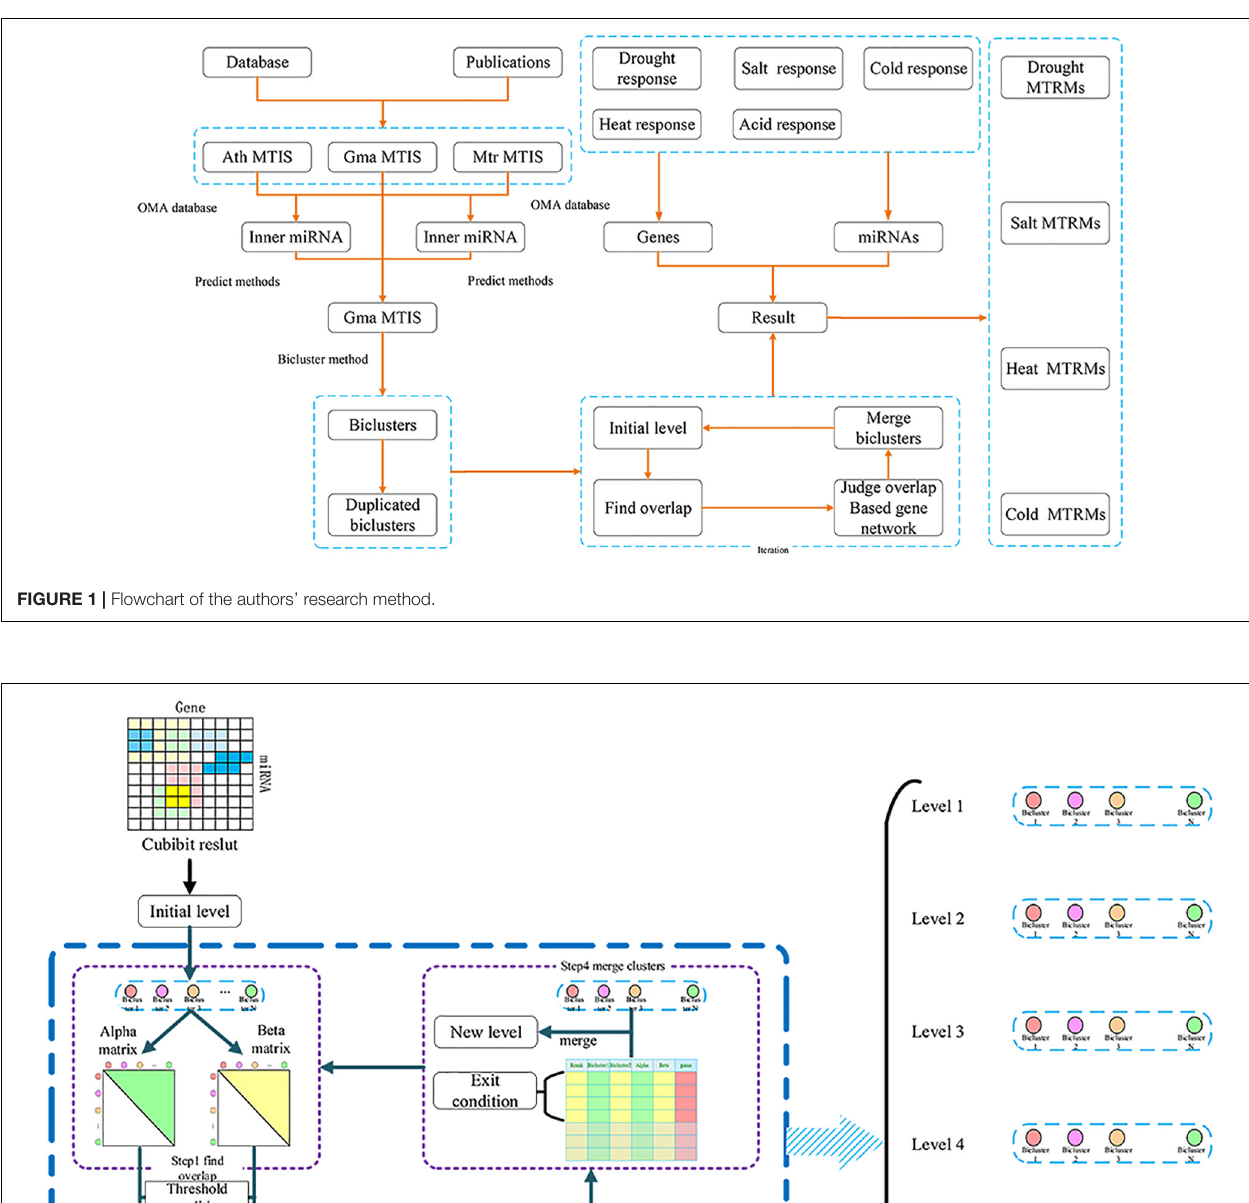
Frontiers in Plant Science |